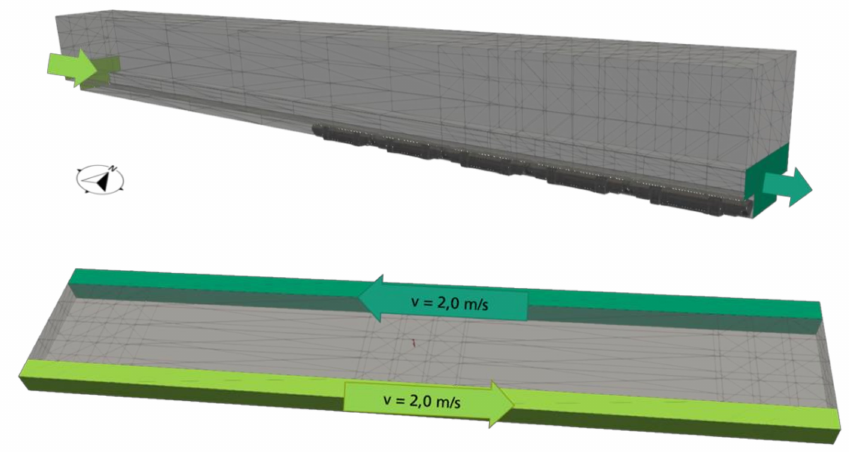
Figure 6. Simulation models of the train hall section ( top ) and an underground station using the example of Munich Central Station and the Odeonsplatz (U3/U6 subway station) in Munich ( bottom